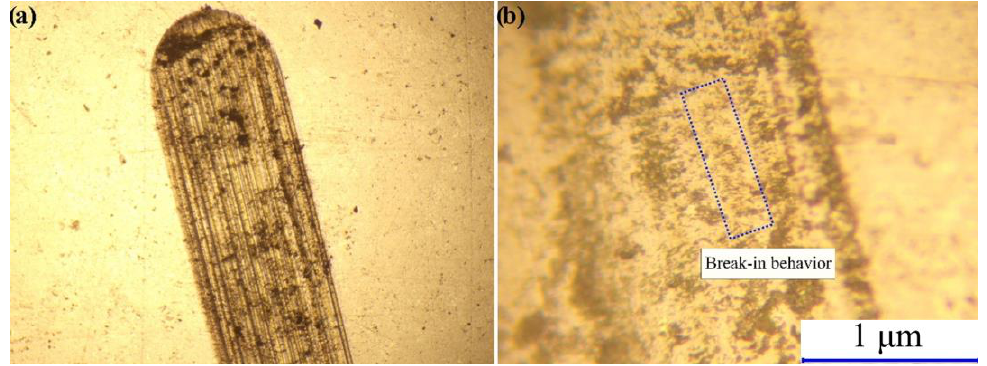
Figure 6. Optical images of the 70Si-BAM surface.